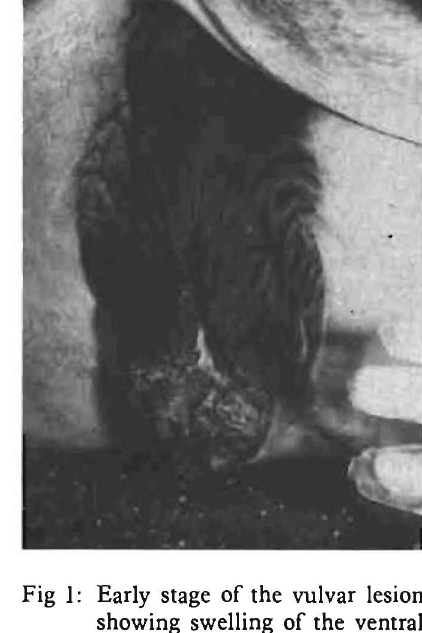
Fig 1: Early stage of the vulvar lesion showing swelling of the ventral vulvar commissure